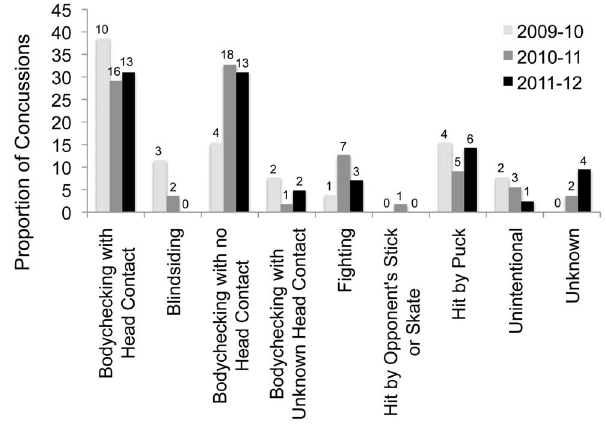
Figure 1. Mechanisms causing NHL concussion. The causes of NHL concussion or suspected concussion were documented for the subset of injuries occurring during the 10 randomly selected weeks for all 3 seasons. The proportion of injuries within each season caused by each mechanism is shown, with the number of injuries above each bar. Unintentional actions included tripping and colliding with a teammate. The rates of each mechanism remained constant over the seasons tested (p . 0.05 for